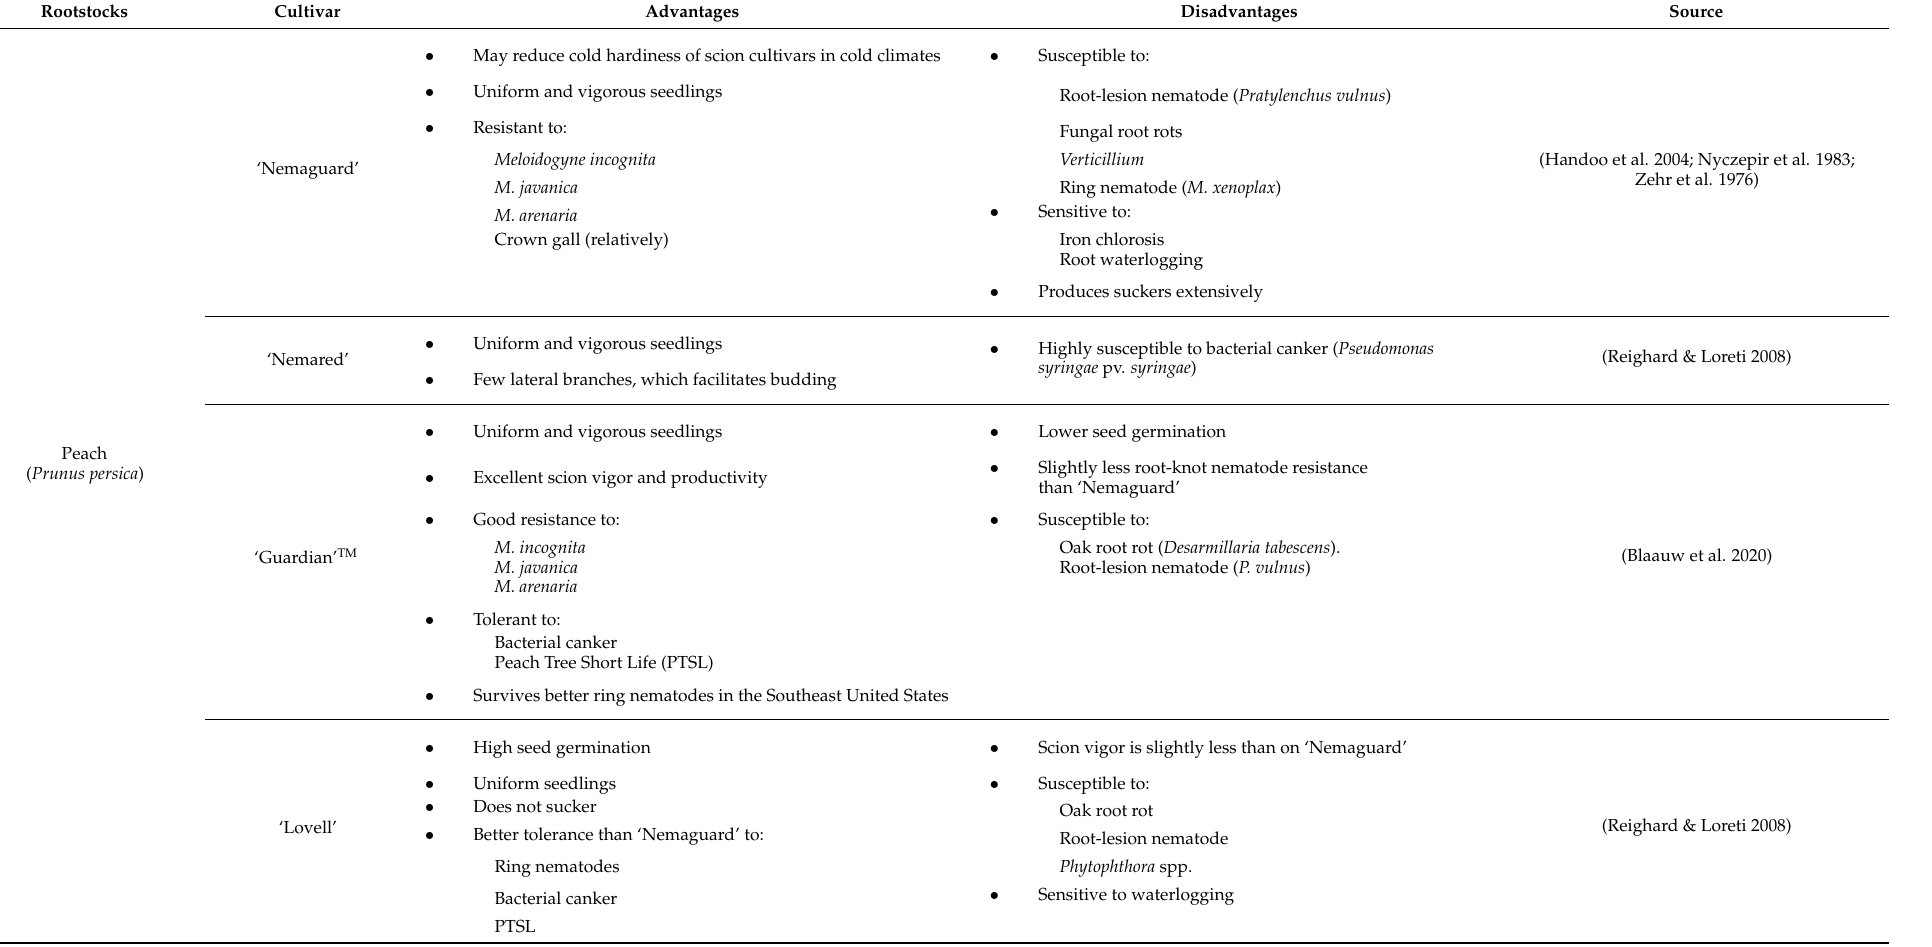
Table 1. A detailed comparison of the advantages and disadvantages of rootstocks for commercial peach production in the Southeastern United